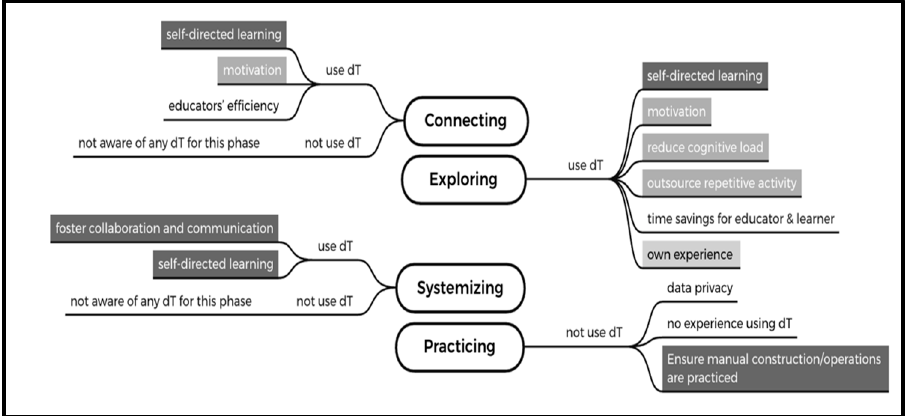
Figure 2. Arguments for or against the use of dT for each teaching phase.